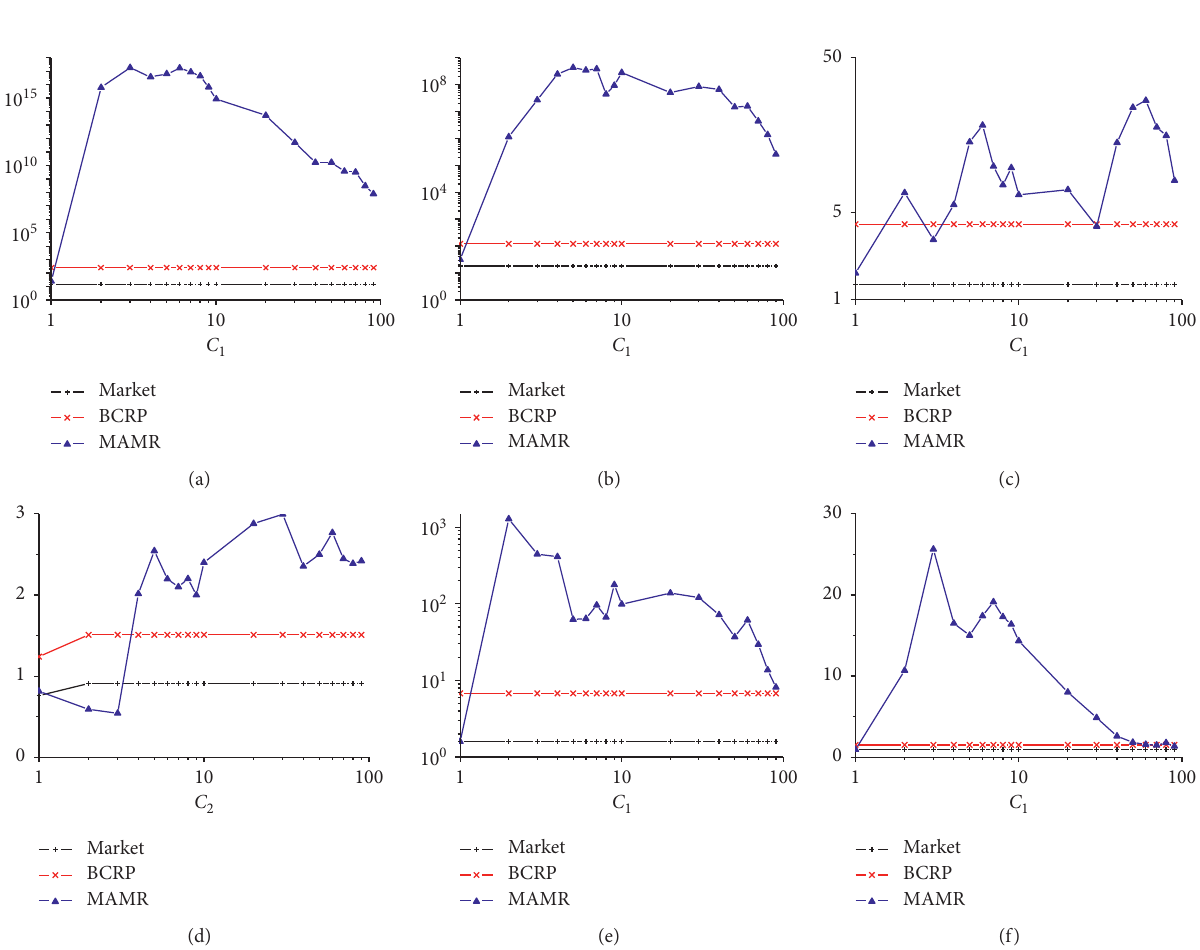
� 100. (a) NYSE(O). (b) NYSE(N). (c) SP500. 2